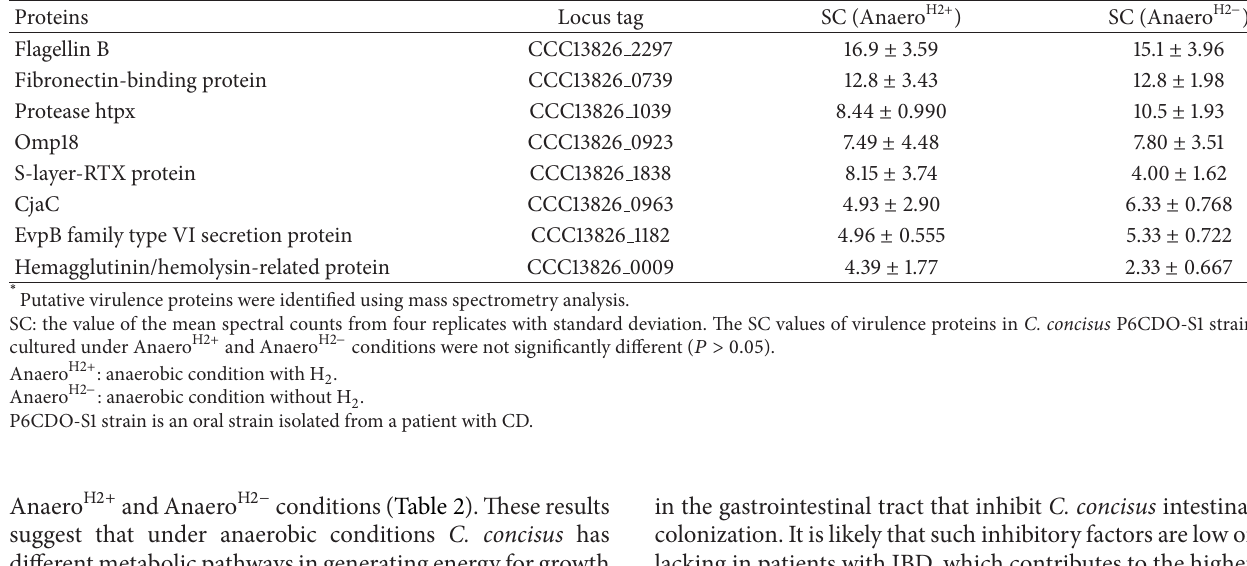
Table 3: Putative virulence proteins expressed by C. concisus P6CDO-S1 strain cultured under Anaero H2+ and Anaero H2 − conditions ∗ .